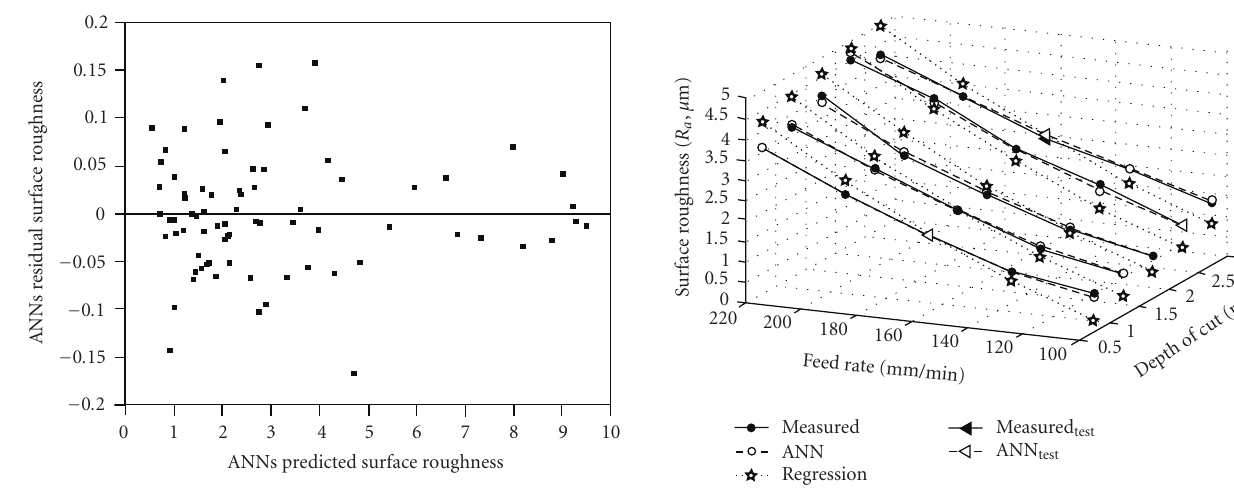
Figure 16: Comparison of actual, regression and ANN approach values for insert radius of 0.8mm.